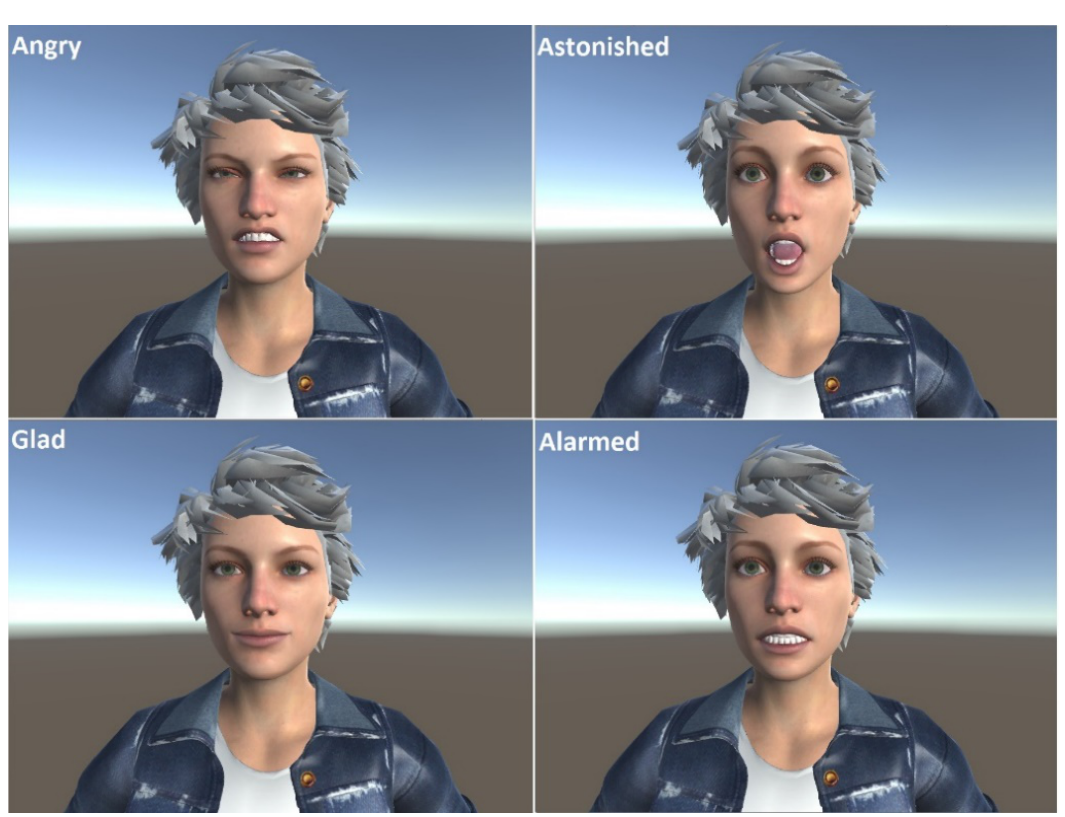
Figure 9. Example of recognised emotions visualised through an ECA